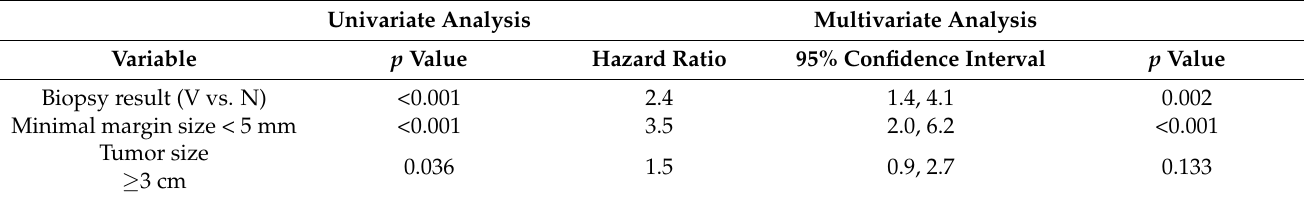
Table 3. Univariate and multivariate analyses of factors associated with local tumor progression by using the competing-risks regression model.